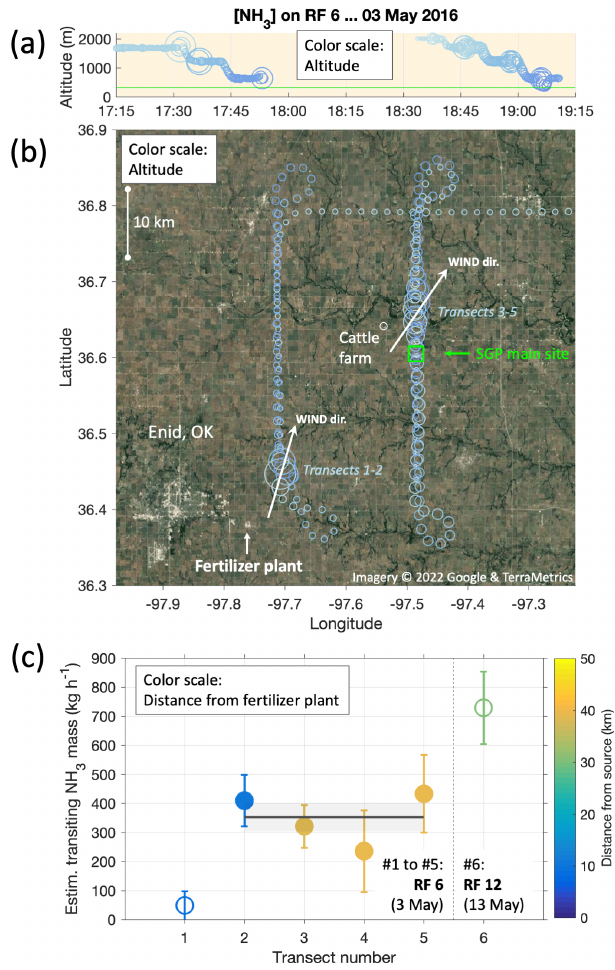
Figure 5. Source rate estimation for a large fertilizer plant (Koch Industries Inc.) in the town of Enid, OK, based on horizontal fluxes calculated from plume transects during RF6 on 3 May. Panel (a) shows the altitude profiles flown from 17:15 to 19:15UTC; panel (b) the corresponding ground tracks in relation to Enid, the fertilizer plant and the SGP ground site (blue square). Circle sizes correspond to measured NH 3 mixing ratios; colors correspond to flown altitudes. Arrows in panel (b) indicate the average wind di- rections for respectively co-located plume transects 1–2 and 3–5. Panel (c) presents the mass of NH 3 transiting in the total plume, es- timated as per on Eq. (1). The weighted mean using the four most reliable transects amounts to 350 ± 50kgh − 1 (gray line and shad- ings). Also shown is a plume transect (#6) during RF12 on 13 May, for which the same calculation yielded 730 ± 125kgh − 1